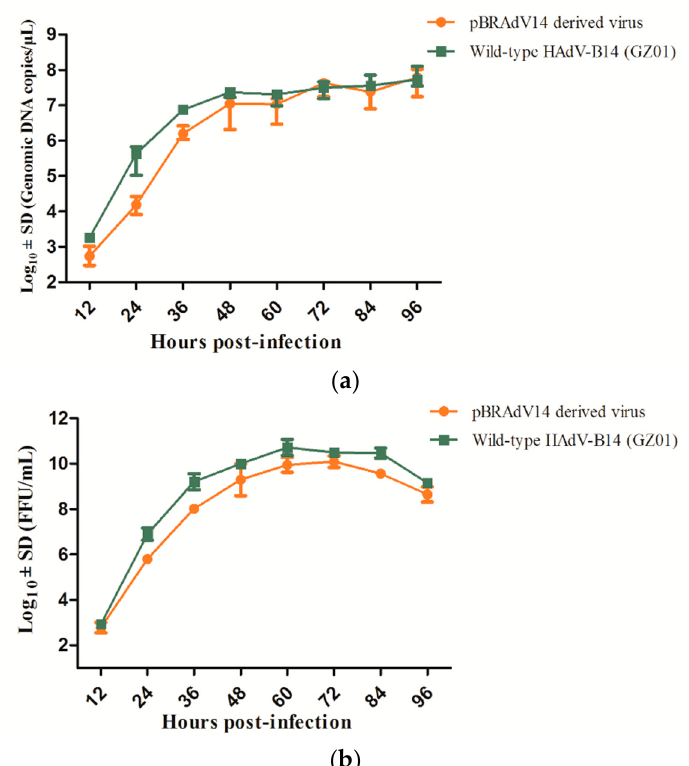
Figure 6. The one-step growth curves of pBRAdV14 – derived viruses and parental HAdV-B14 GZ01 strain. Cells were harvested at 12, 24, 36, 48, 60, 72, 84 and 96 h post-infection of these two different origins of viruses at an MOI (multiplicity of infection) of 0.02. ( a ) Viral genomic DNA copy numbers in harvest viral culture were determined by quantitative PCR with Q-PCR kit (Huayin Corp.; Guangzhou, China); ( b ) infectious viral particles were quantified by fluorescence forming units (FFU) per ml as described in Materials and Method.